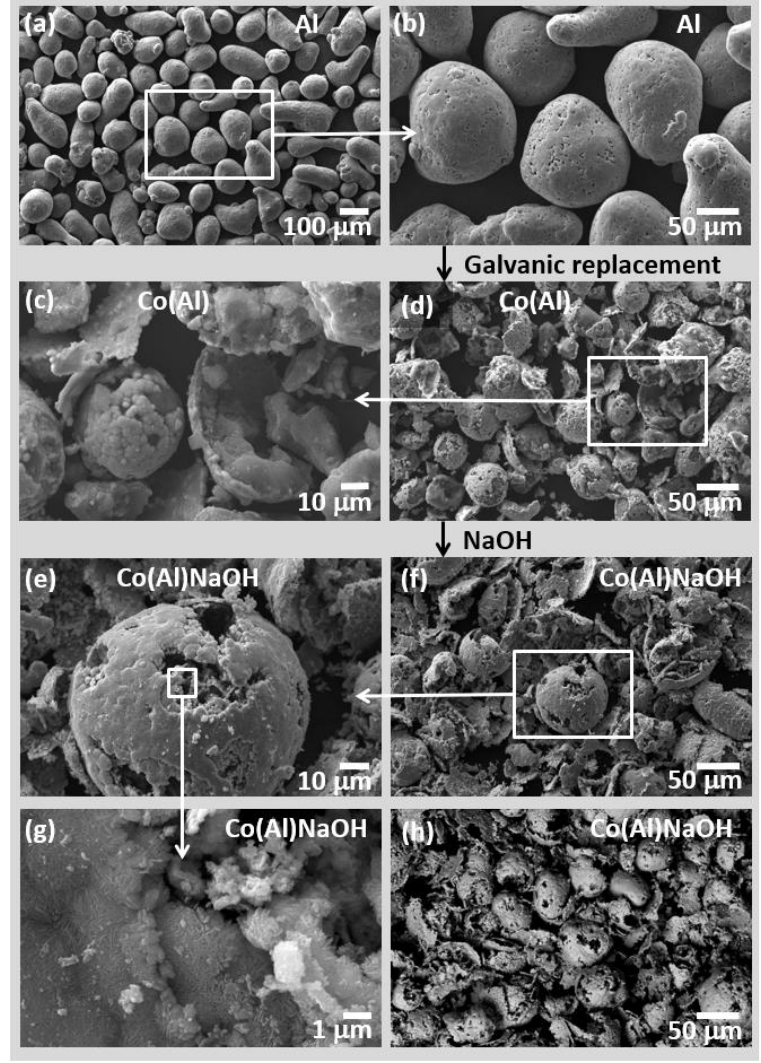
Figure 3. SEM images of initial Al powder ( a , b ) and synthesized Co(Al) ( c , d ) and Co(Al)NaOH ( e – h ). The synthesized Co(Al) catalyst is magnetic and instantly collected on a magnet (Fig- ure 2b). In addition to easy separation from the reaction medium, the pronounced mag- netic properties of the Co(Al) catalyst make it possible to stir the NaBH 4 hydrolysis me- dium under the action of an external magnetic field without using a magneton (Figure S4). Furthermore, stirring Co(Al) results in a higher hydrogen yield and a two-fold reduction in reaction time when compared to a static state. In the literature, Pd/C-dots@Fe 3 O 4 [35] and Co@g-C 3 N 4 -rGO [34] magnetic catalysts were also used in the self-stirring mode. As noted above, the Co(Al) catalyst contains 10.5 wt% of Al. Under the conditions of NaBH 4 hydrolysis used in this work, aluminum does not contribute to the generation of